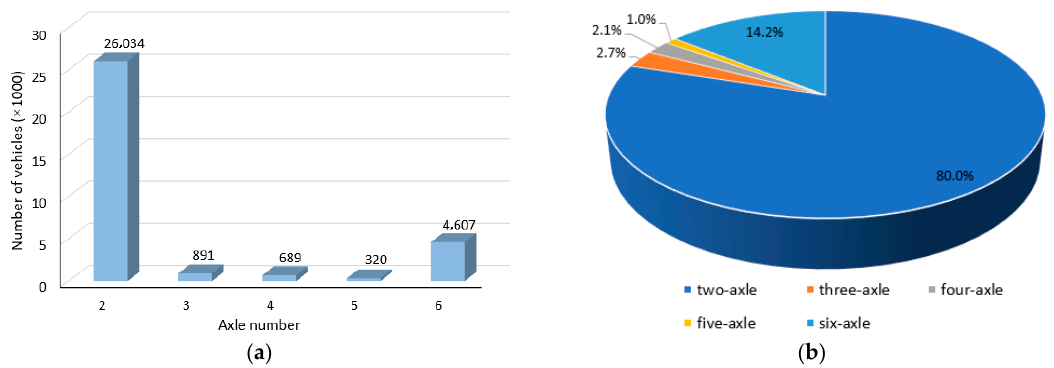
Figure 10. Axle distribution on 16 March 2016. ( a ) Histogram ( b ) Sector diagram.